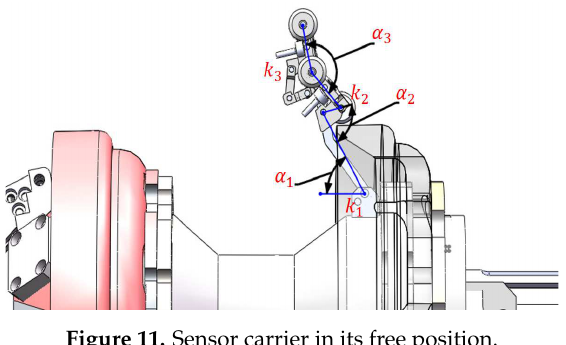
Figure 11. Sensor carrier in its free position. Table 1. Torsion spring parameters and their conditions for straight, concave, and convex pipe sections. Straight Concave Convex Torsion